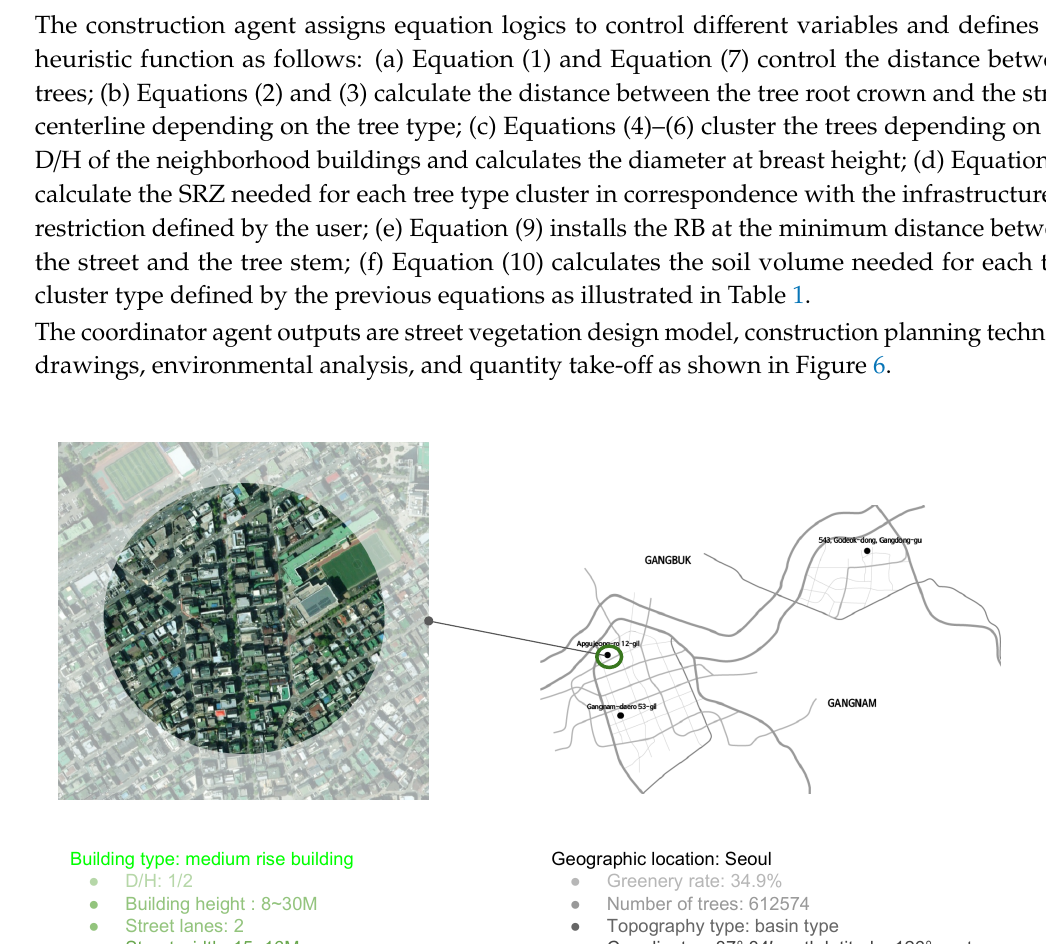
Figure 4. An illustration of the T-Agent design tool’s data process workflow and its comparison to T- Design decision-making process.